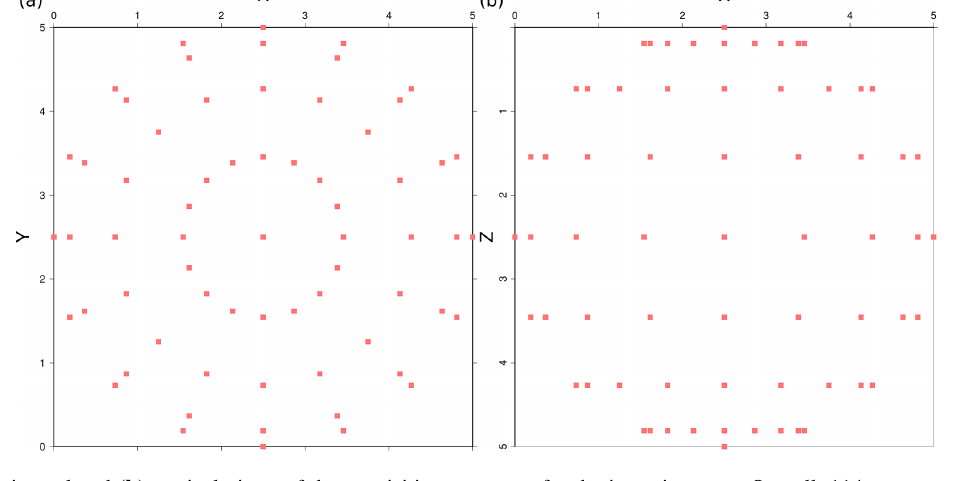
Figure 1. (a) Horizontal and (b) vertical views of the acquisition geometry for the inversion tests. Overall, 114 sources and 114 receivers (red boxes) are located at 2.5km from the center of the model at the locus defined by the surface of the sphere inscribed in the cube and placed at the crossing points of 16 meridians with 7 parallels and at each pole. Thus, in the inversion tests, we used 12882 travel times from 114 sources, each recorded at 113 receivers; i.e., all receivers record all sources, except for the one coinciding in location. The acquisition geometry for the accuracy and sensitivity tests is similar, only in this case for sources and receivers at the crossing points of 32 meridians and 15 parallels, plus one of each at the two poles, and using just 482 travel times from diametrically opposed source–receiver pairs arranged; i.e., each receiver exclusively records the first-arrival travel time from its paired